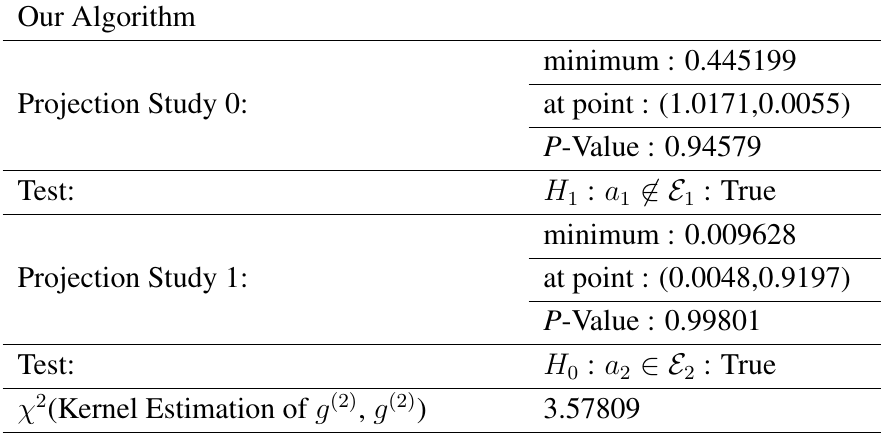
Table 3. Simulation 1: Numerical results of the optimisation.